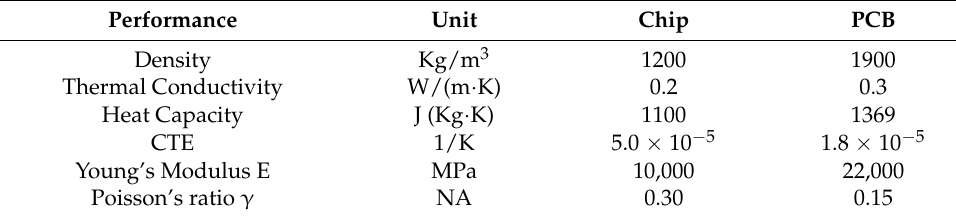
Table 8. Chip and PCB material properties input in 2D FEA modeling.